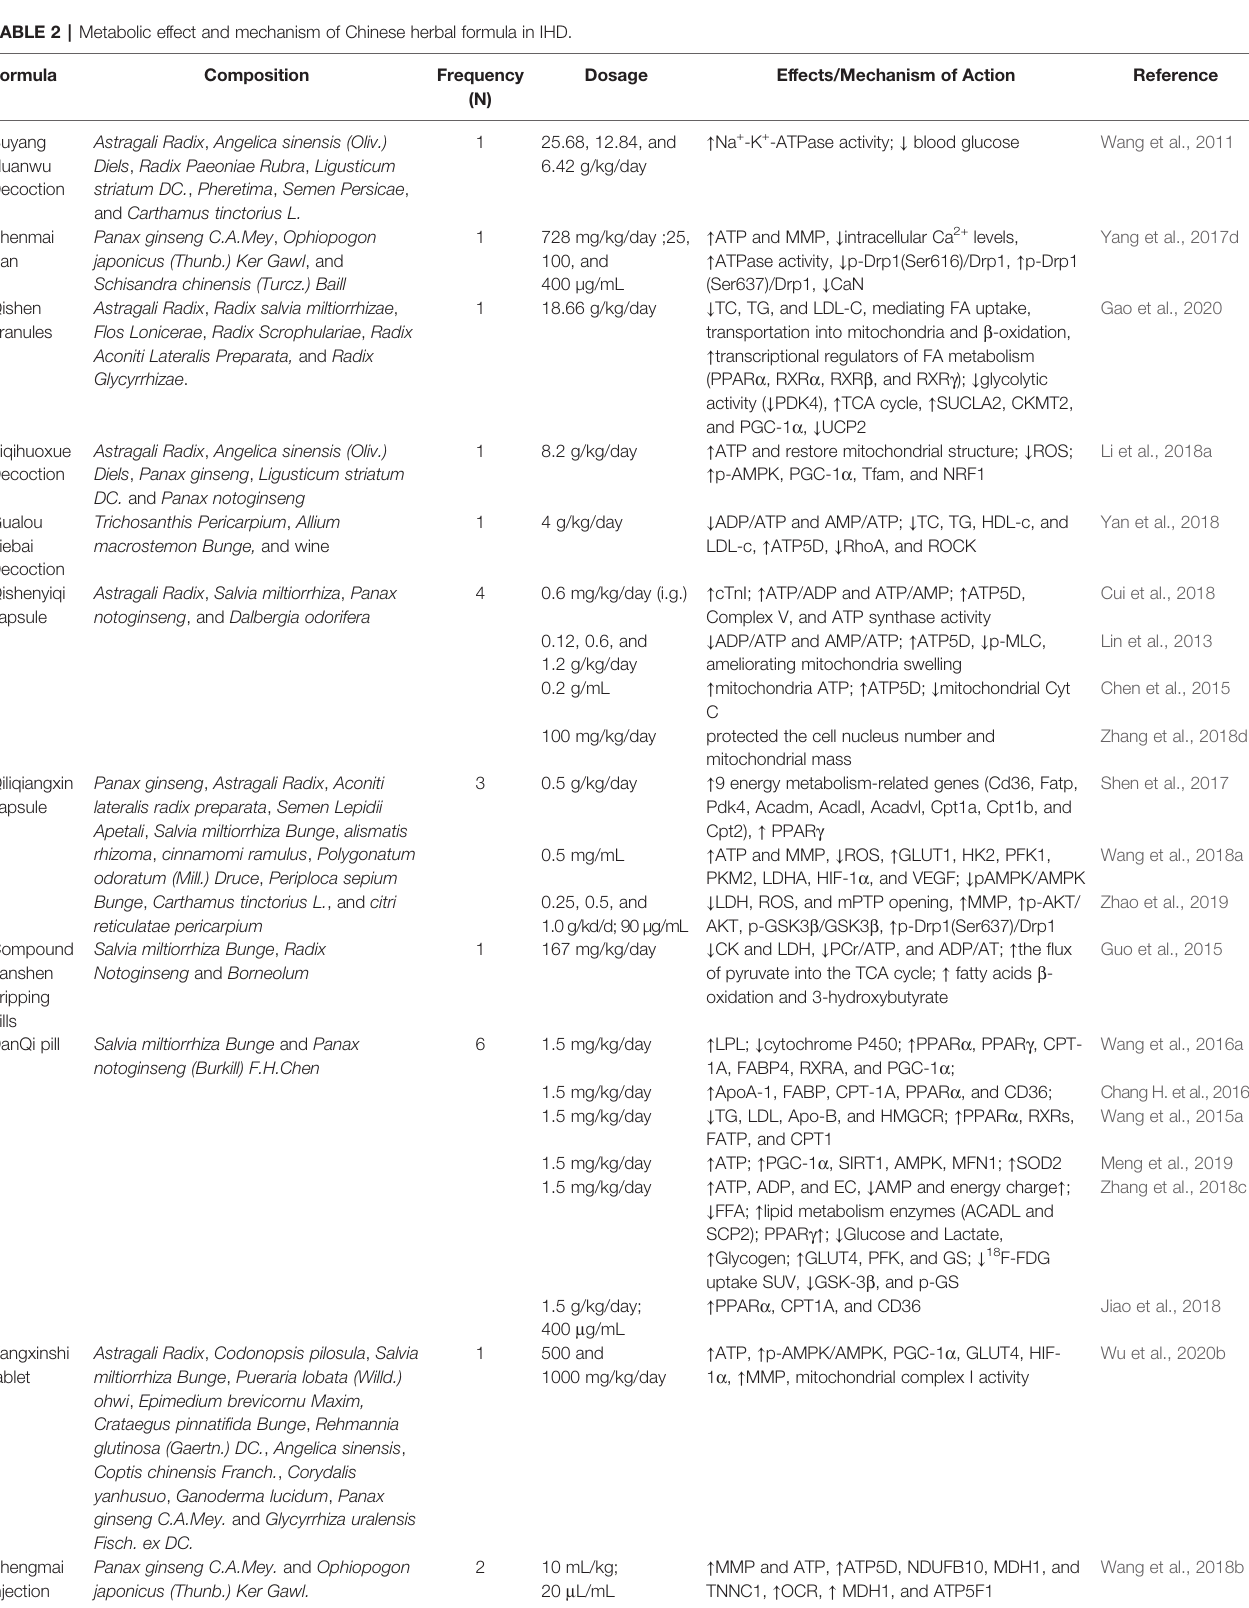
TABLE 2 | Metabolic effect and mechanism of Chinese herbal formula in